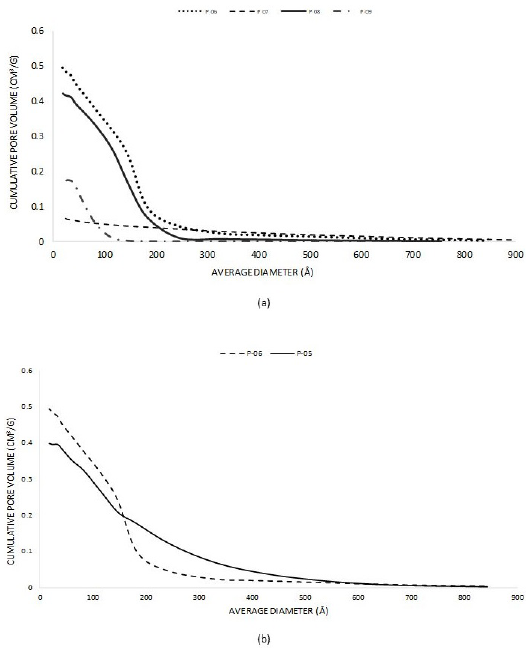
Figure 5. (a) Pore size distribution curves of the copolymers P-06, P-07, P-08 and P-09 (b) Pore size distribution curves of the copolymers P-05 and